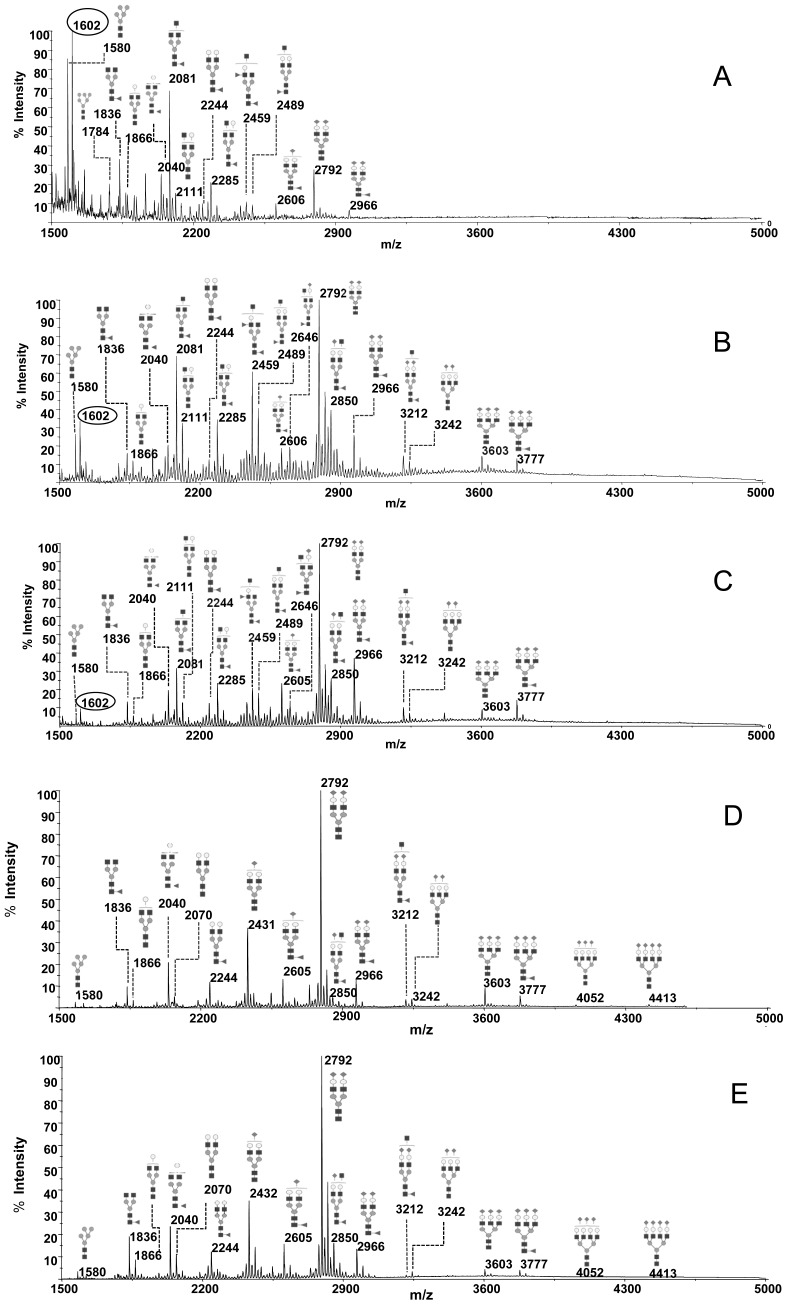
MALDI spectra of permethylated N-glycans derived from plasma and CSF from control or affected eIF2B-mutated patients.
A) Profile I CSF from control patient (G1693); B) Profile II CSF from control patient (CR15); C) CSF from eIF2B-mutated patient (G630-1). D) Plasma from control patient (NIC LUG 28 years); E) Plasma from the eIF2B-mutated patient (G630-1). The other structures not annoted here due to the complexity of the Figure are listed in Table S1. Fucose (Fuc): triangle, Mannose (Man): grey circle, N-acetyl glucosamine (GlcNAc): square, Galactose (Gal): white circle; Sialic acid (NeuAc): lozenge.